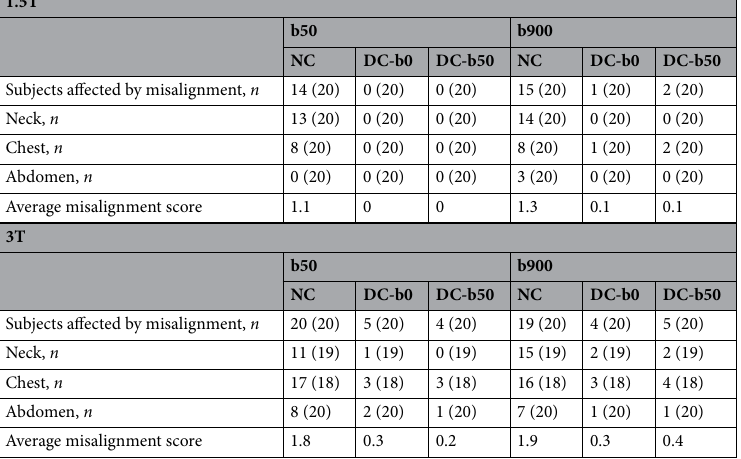
Table 3. Visual assessment of spine misalignment at station boundaries for NC, DC-b0 and DC-b50 data, at 1.5T (top) and 3T (bottom). At both field strengths, b50 and b900 images are evaluated. The total number of subjects affected by spine misalignments are displayed, as well as the number of subjects with spine misalignments at the different anatomical locations along the spine (neck, chest and abdomen). In parentheses the total number of evaluable subjects are displayed. At 3T, large signal dropout for 1 subject at the neck and 2 subjects at the chest meant that the total number of station boundaries that could be evaluated at these locations were 19 and 18, respectively. The average misalignment score across all subjects is also given. NC non-corrected, DC-b0 b0-based distortion correction, DC-b50 b50-based distortion correction.